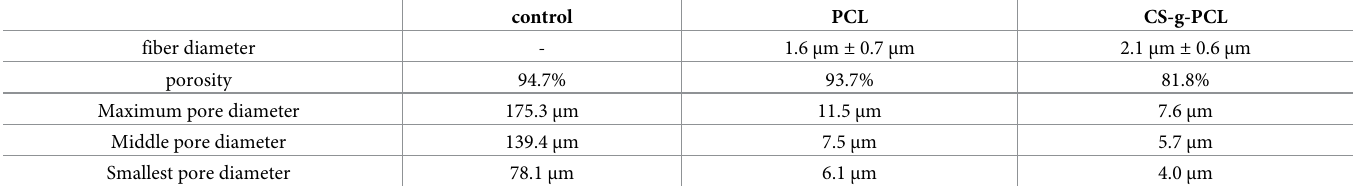
Table 1. Fiber diameter in μ m, porosity in %, the maximum pore diameter in μ m, the middle pore diameter in μ m and the smallest pore diameter in μ m of the con- trol group scaffold (control; see Gniesmer et al., 2019), the unmodified PCL fiber mat group (PCL) and the PCL fiber mat modified with CS-g-PCL group.